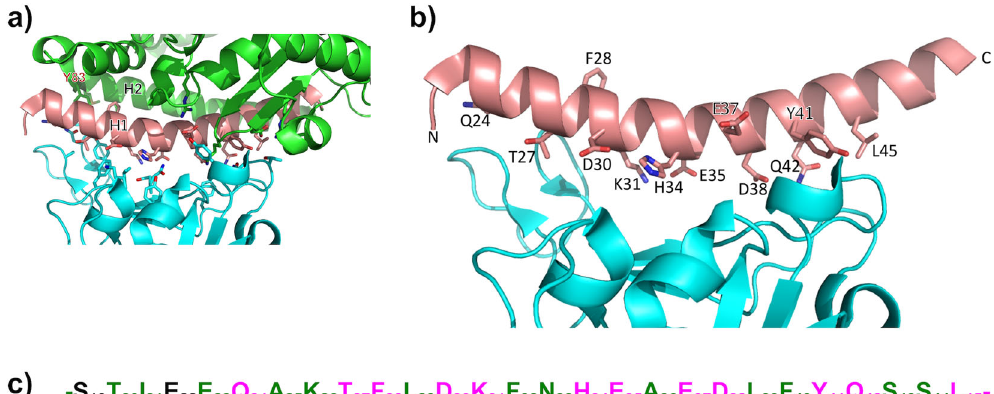
Fig. 1 Structure of the complex between hACE2 and the spike protein of SARS-CoV-2 (pdb 6m0j) 14 . a Contact residues of the hACE2 / SARS-CoV-2 spike interface. hACE2 protein is colored in green, apart from N-terminal helix H1 which is highlighted in salmon. SARS-CoV-2 spike protein is shown in cyan. b Residues of hACE2 H1 helix interacting with spike. c Sequence of hACE2 H1 helix showing the 12 interacting residues in magenta. Residue positions in green were considered as possible substitution sites for the helical peptide